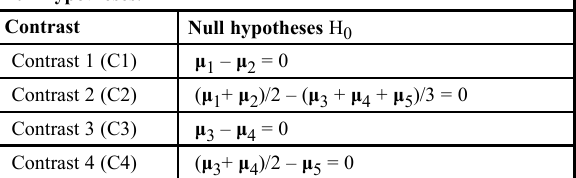
Table 4a: Mutually orthogonal linear contrasts and corresponding null